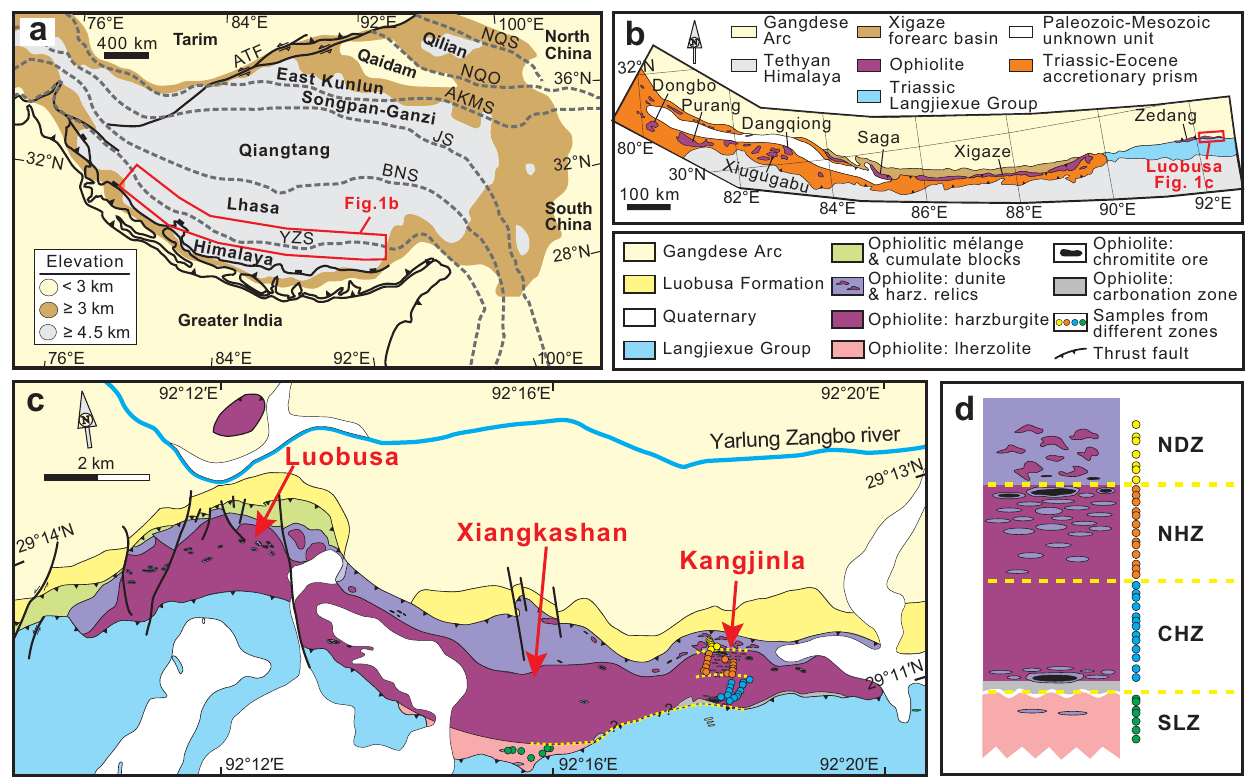
Fig. 1 | Simpli fi ed tectonic and geological maps showing the Kangjinla ophio- liticmantleintheYarlung ZangboSuture(SouthTibet). Majortectonic units of the Himalayan-Tibetan orogenic system ( a ; modi fi ed from DeCelles et al. 67 ), geo- logical sketch map of South Tibet showing the Yarlung Zangbo Suture and major ophiolites ( b ; modi fi ed from Dai et al. 68 ), and the simpli fi ed geological map illus- trating the Luobusa ophiolite and adjacent tectonic units ( c ; modi fi ed from Liang et al. 69 ). This study focused on the Kangjinla segment and the southernmost por- tion of the Xiangkashan segment, both of which display intact occurrence, direct exposure, and minimum alteration. We collected representative peridotites by hammersonthewell-exposedoutcropswithsamplingspacingofseveraltotensof